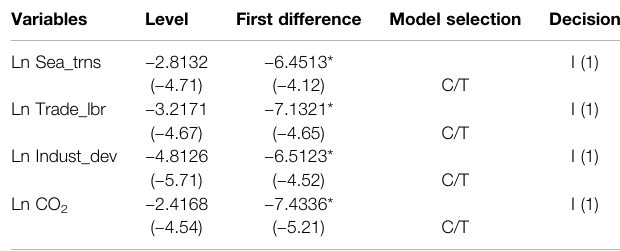
TABLE 1 | Phillips-perron (PP) unit root test results of China. Variables PP ( fi xed and trending) (level 0)